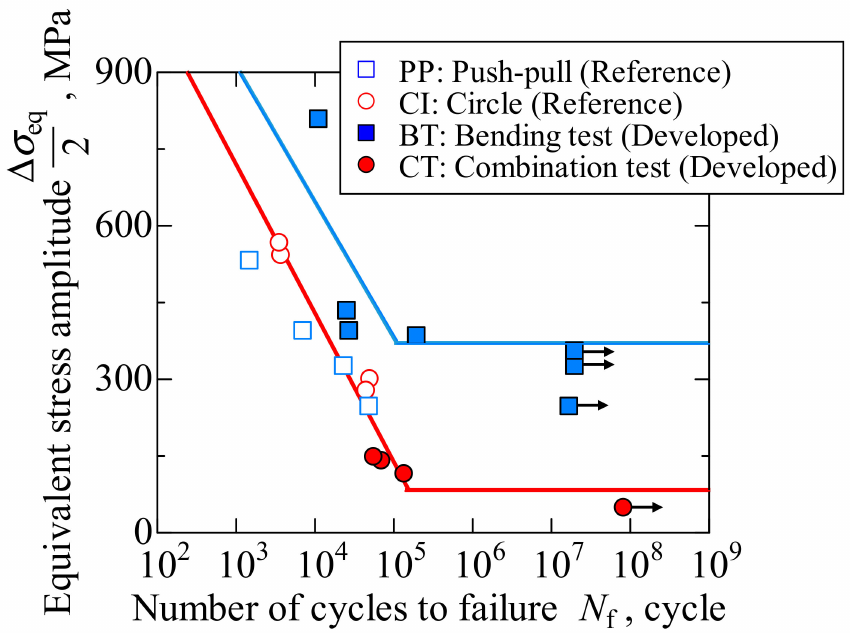
Figure 11. Fatigue test results for type 304 steel.